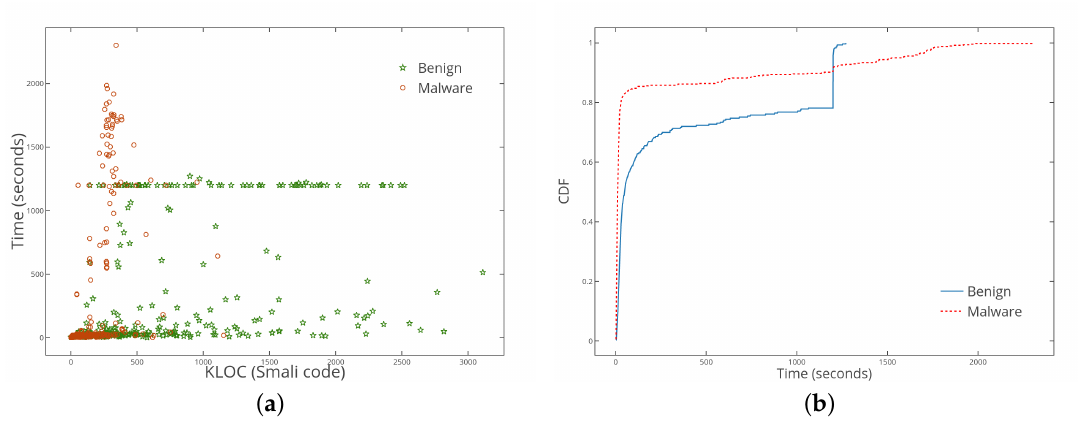
Figure 8. Analyzing time of FlowDroid. ( a ) analyzing time of FlowDroid; ( b ) cumulative distribution